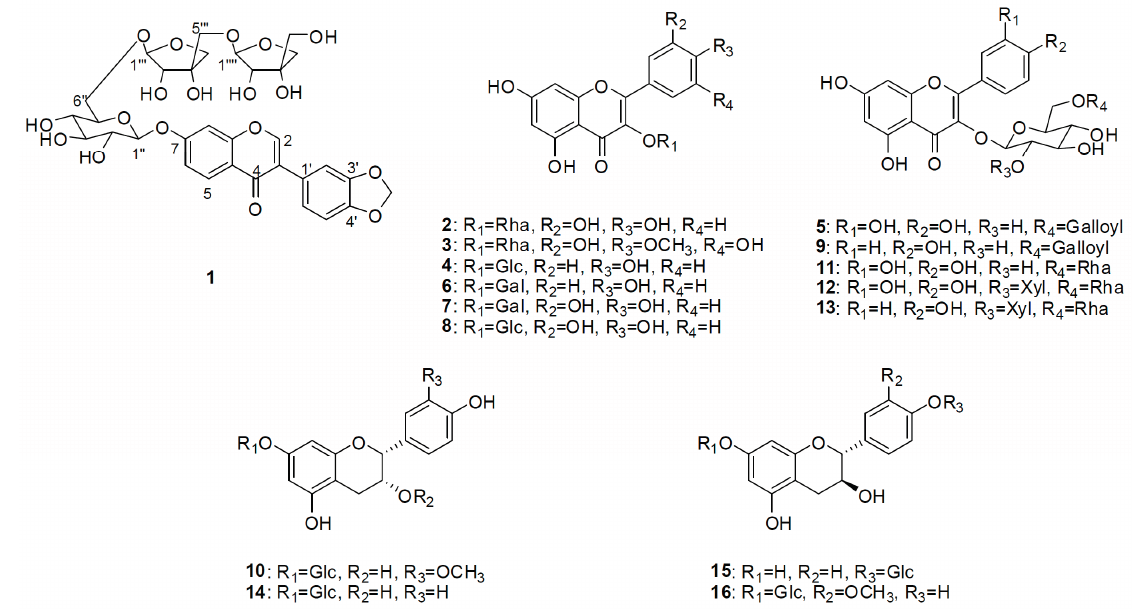
Figure 1. Chemical structures of compounds 1 – 16 from Symplocos